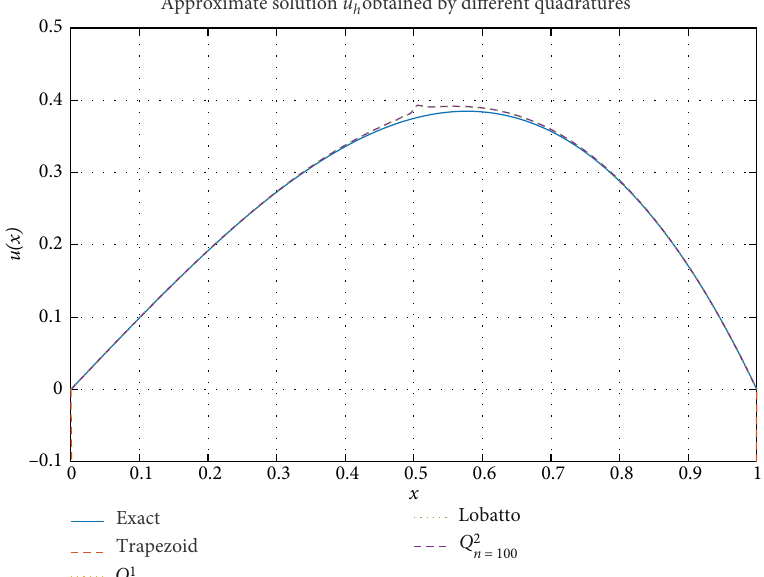
Figure 2: Exact solution